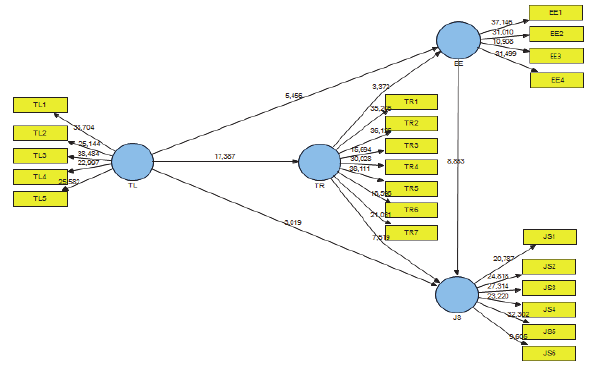
Fig. 3. Output Bootstrapping (Source: SmartPLS 2.0 data